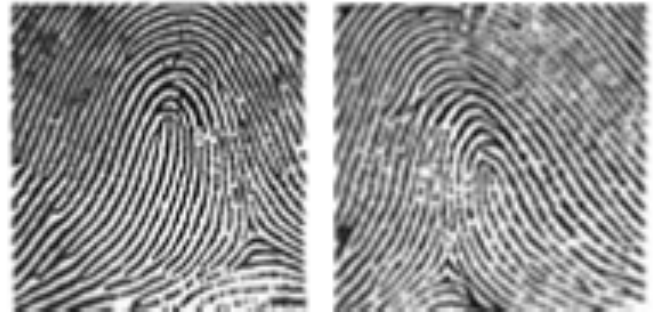
Figure 4. Example type of fingerprint is